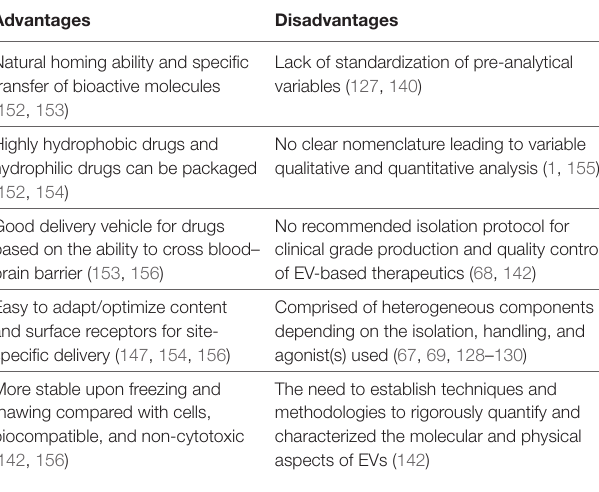
TABLe 2 | Advantages and disadvantages of extracellular vesicles (EVs) as emerging therapy for cardiovascular